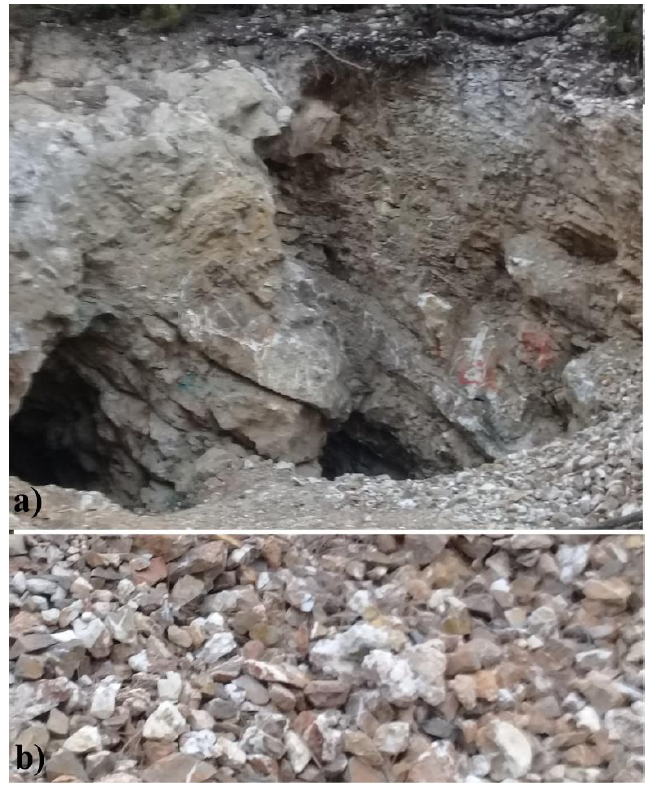
Figure 5. Mine activity in MVT Ag-Pb-Zn deposit. ( a ) underground galleries. ( b ) Material extracted from mining. The subfigures do not need a scale bar.